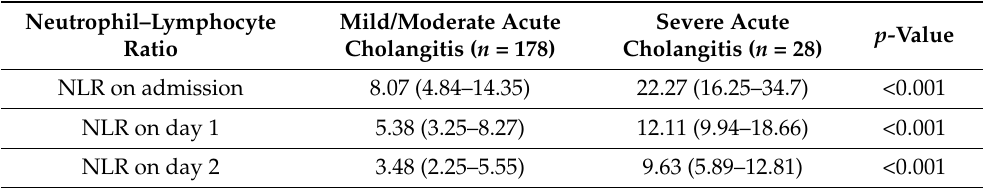
Table 3. Changes over time in the neutrophil–lymphocyte ratio in the mild/moderate and severe acute cholangitis